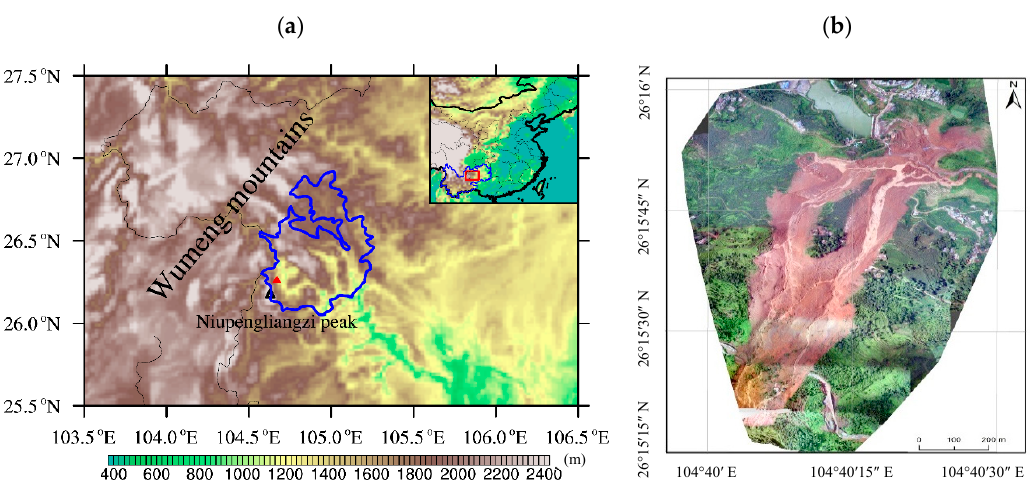
Figure 1. ( a ) The topographical distribution of the Wumeng Mountains and ( b ) an image of the Shuicheng County landslide and debris flow of 23 July 2019 after cessation, Source: Guizhou Earthquake Administration (http://www.gzsdzj.gov.cn/xygl/yjcz/201907/t20190726_5304724.html). The red solid triangle represents the location of the landslide; Shuicheng County is outlined in blue. In the inset map of panel ( a ), the Yunnan–Guizhou Plateau is outlined in blue, and the area of interest is outlined with a red box.